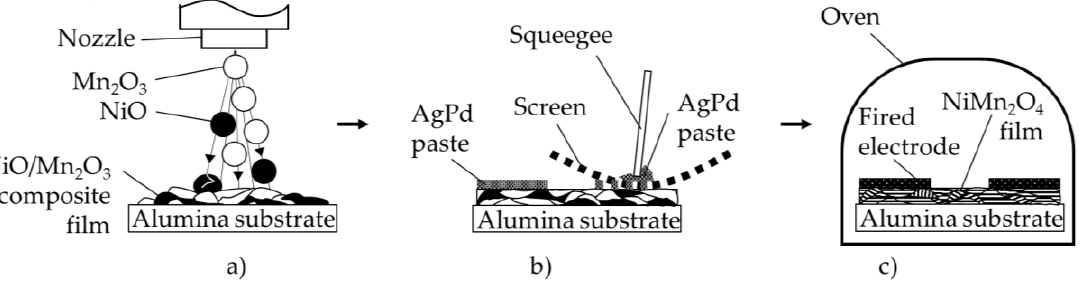
Figure 1. Scheme of the novel NTC thermistor production route, ( a ) aerosol co-deposition (AcD) of the powder mixture of NiO and Mn 2 O 3 ; ( b ) application of an electrode structure by screen-printing; ( c ) combined electrode sintering with spinel formation and film tempering.